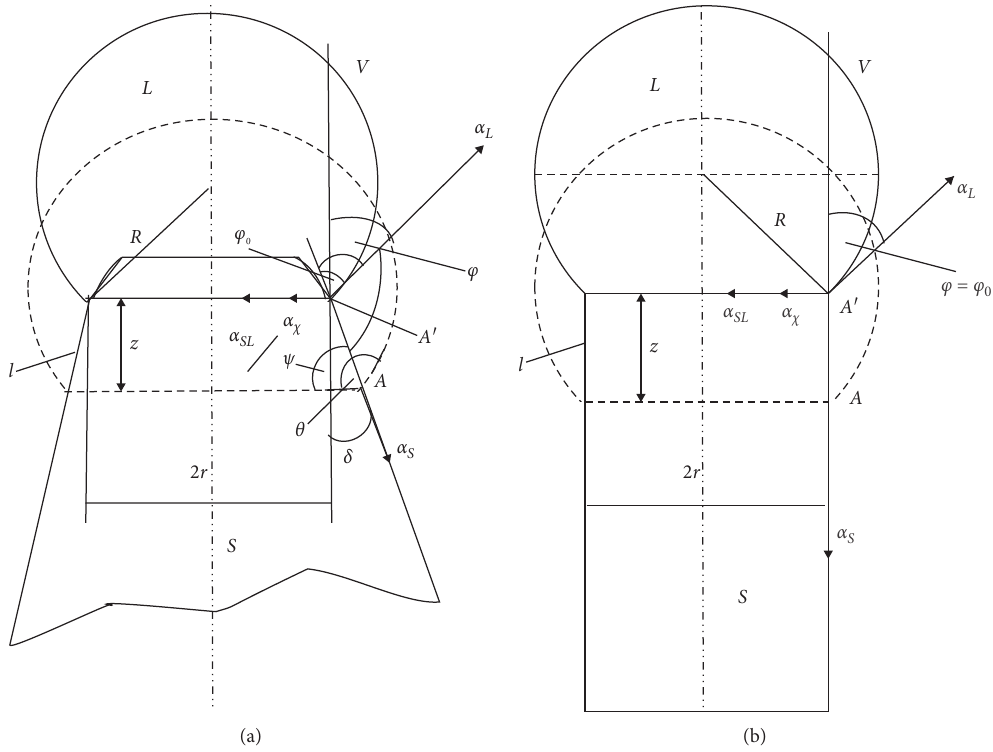
Figure 1: Wetting model of VLS growth of NWs: ( a ) conical ( δ > 0) and (b) constant radius ( δ �